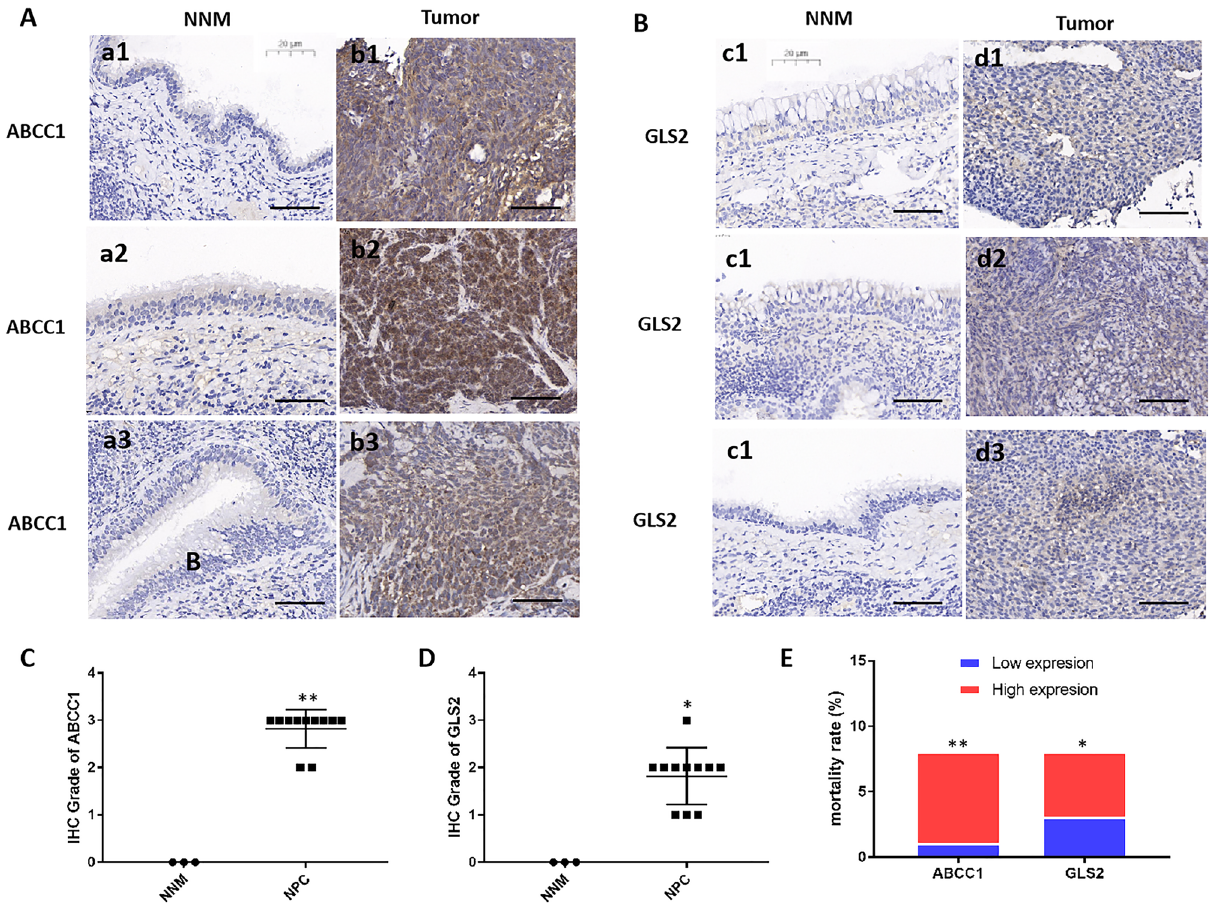
Figure 10. The expression and prognosis of ABCC1 and GLS2 in NPC tissues. ( A,B ) The expression of ABCC1 and GLS2 in 3 nasopharyngeal carcinomas and adjacent non-tumor tissues by IHC. The scale bar was 20 μm. ( C,D ) Statistical analysis to assess the expression level of ABCC1 and GLS2 in NPC tissues. ( E ) Mortality rate testing assessed the correlation between ABCC1 and GLS2 low/high expression with the poor survival of the patients. *p < 0.05, **p <